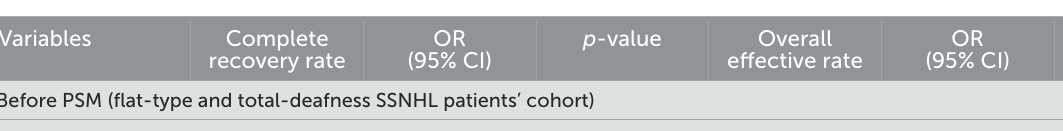
TABLE 4 Complete recovery rate and overall effective rate before and after propensity score matching in the sensitivity analysis.